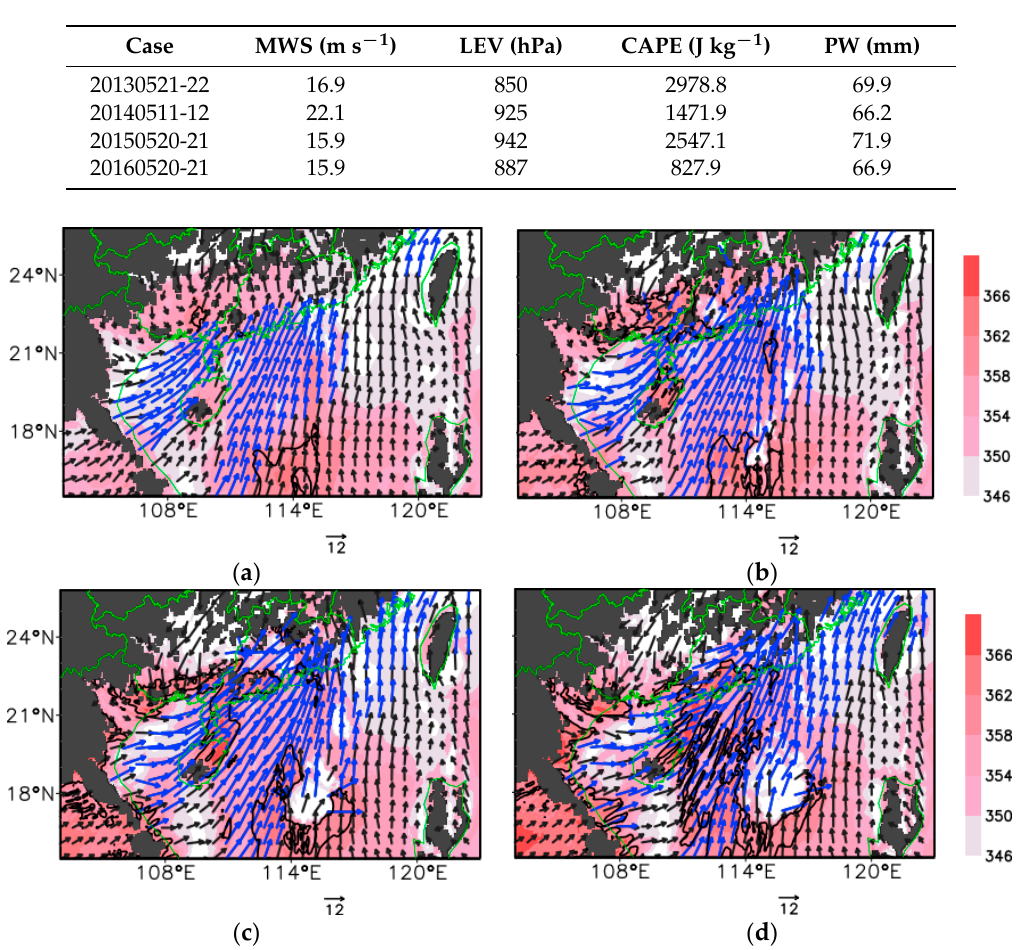
Table 1. Parameters within the PBL according to the Hong Kong sounding during the WSTR in May from 2013 to 2016. MWS denotes the maximum wind speed, and LEV represents the corresponding level, whereas PW denotes the precipitation water for the entire sounding.